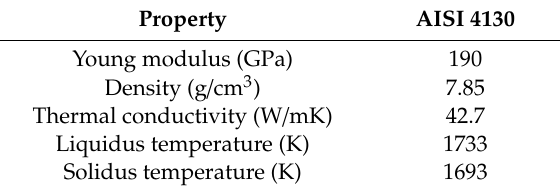
Table 3. Mechanical and thermo–physical properties of AISI 4130.